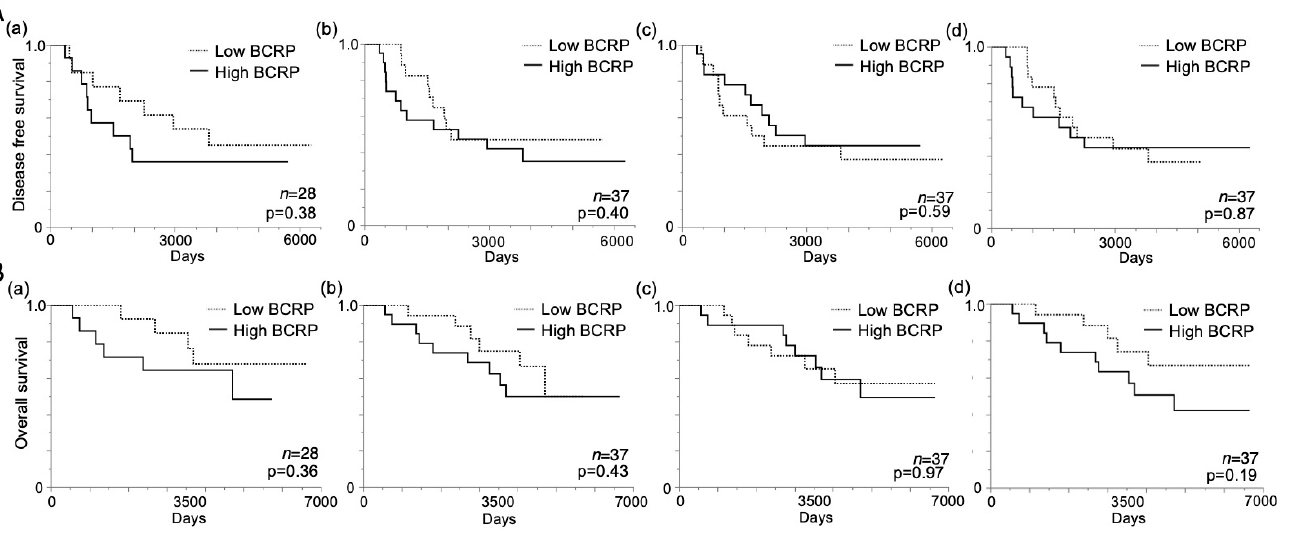
Figure 3. Kaplan–Meier disease-free survival (DFS) and overall survival (OS) curves according to BCRP expression. ( A ) DFS according to median BCRP expression in ( a ) core needle biopsy (CNB), ( b ) primary tumor, ( c ) metastatic lymph node, and ( d ) primary tumor and metastatic lymph node samples. ( B ) OS according to the median BCRP expression in ( a ) CNB, ( b ) primary tumor, ( c ) metastatic lymph node, and ( d ) primary tumor and metastatic lymph node samples; p -values were determined using the log-rank test. Table 3. Correlations between BCRP-PID score and recurrence or survival.